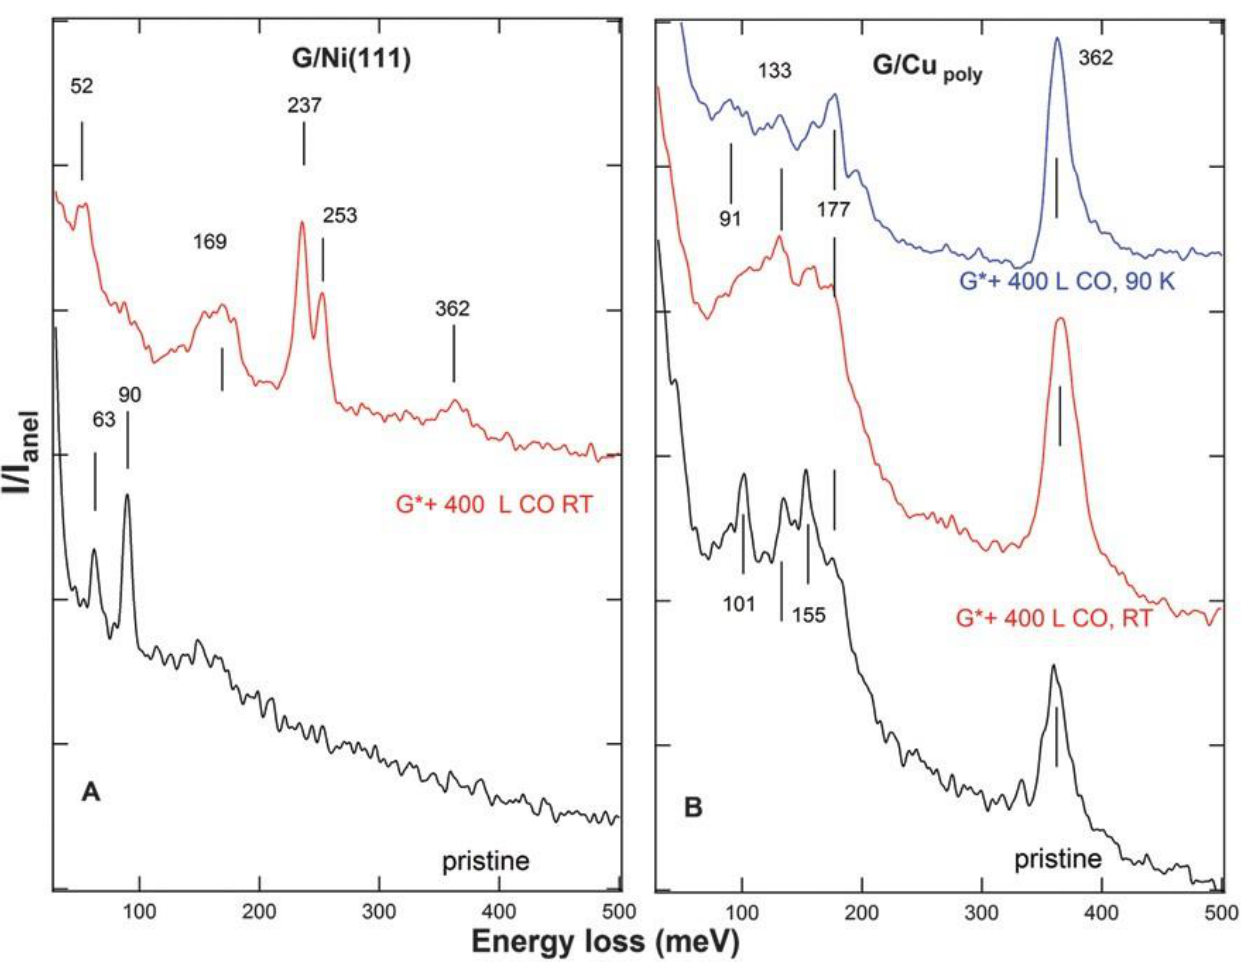
Figure 7. HREEL spectra of G/Ni(111) (panel A ) and G/Cu polycrystalline (panel B ). The bottom traces (black) refer to the pristine samples, the top ones to the layer after sputtering ( Ne+ = 3.2 × 10 14 Ne + /cm 2 ) and exposure to 400 L of CO at RT (red, A and B ) ad at 90 K (blue, B only). Taken with permission from Ref. [20]. Copyright by the Royal Society of Chemistry.